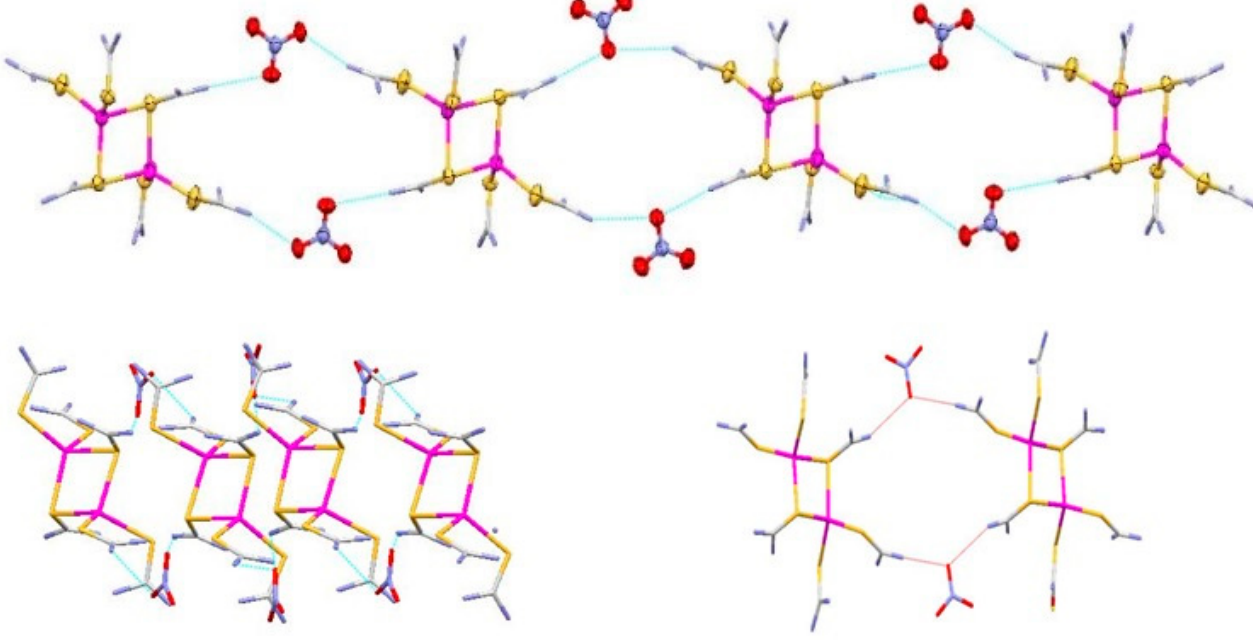
Figure 7. 2D representation of 2 , the network is stabilized by intramolecular N-H---O hydrogen bonding.